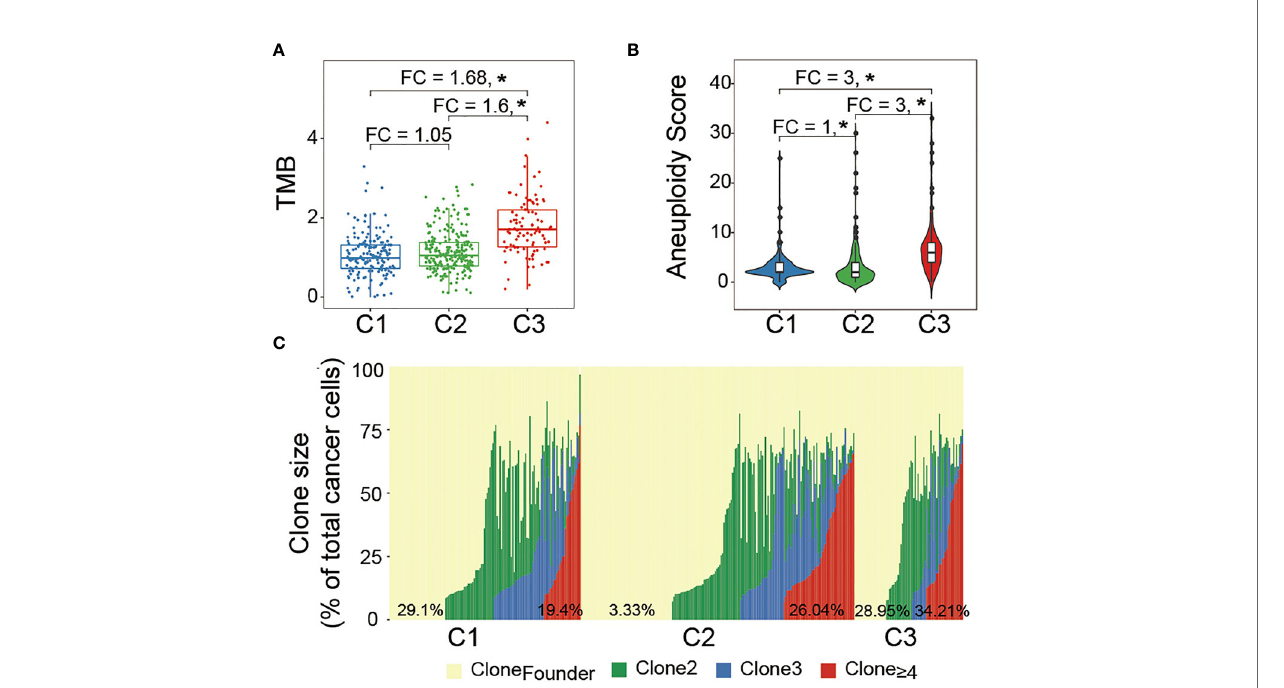
FIGURE 3 | Intratumoral heterogeneity comparison between LGG subtypes: (A) median TMB was compared between groups. Statistical signi fi cance was determined by the Mann – Whitney U test. (B) Median aneuploidy score was compared between groups. (C) Major clone (Clone 1) laid at the background and subsequent subclone was superimposed upon the previous clone. The horizontal axis represents each LGG sample while the vertical axis represents the cellular fraction of each clone marked by a different color for the corresponding LGG sample. The percentage at the bottom indicates the fraction of LGG samples belonging to each clone. *P <